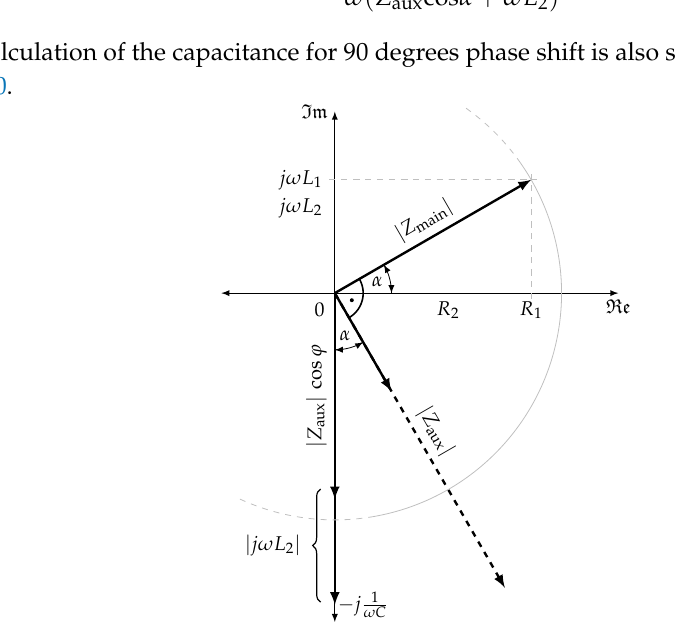
Figure 10. Vector diagram of calculation for a fixed 90 degrees phase shift of